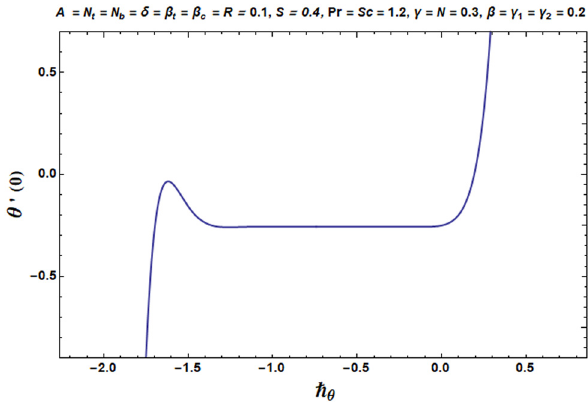
Figure 3: H curve stimulus for θ ′ 0 ( )